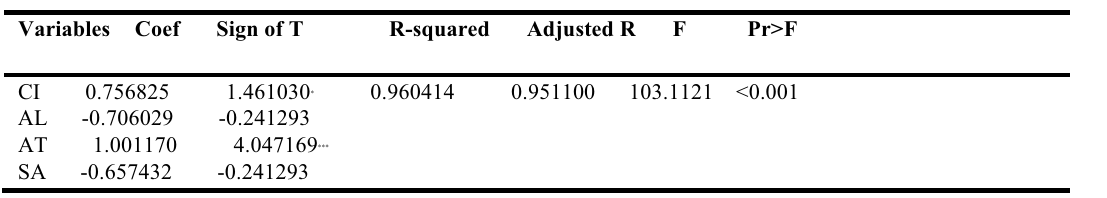
Table 2. Regression